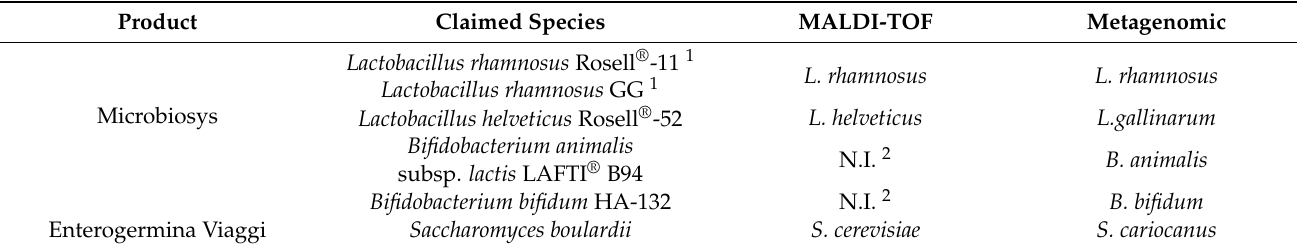
Table 2. Identification of the microbes contained in the